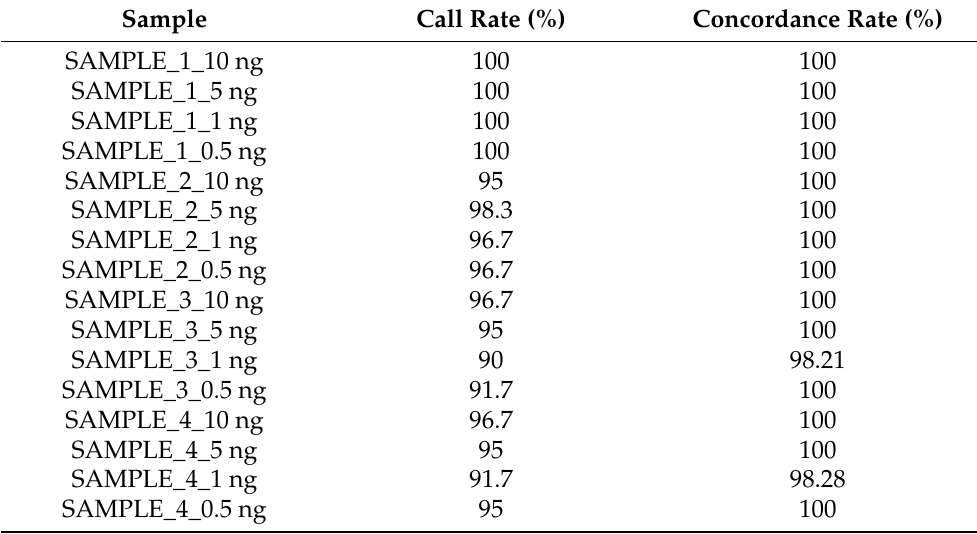
Table 3. The call rate and concordance rate obtained from the sensitivity